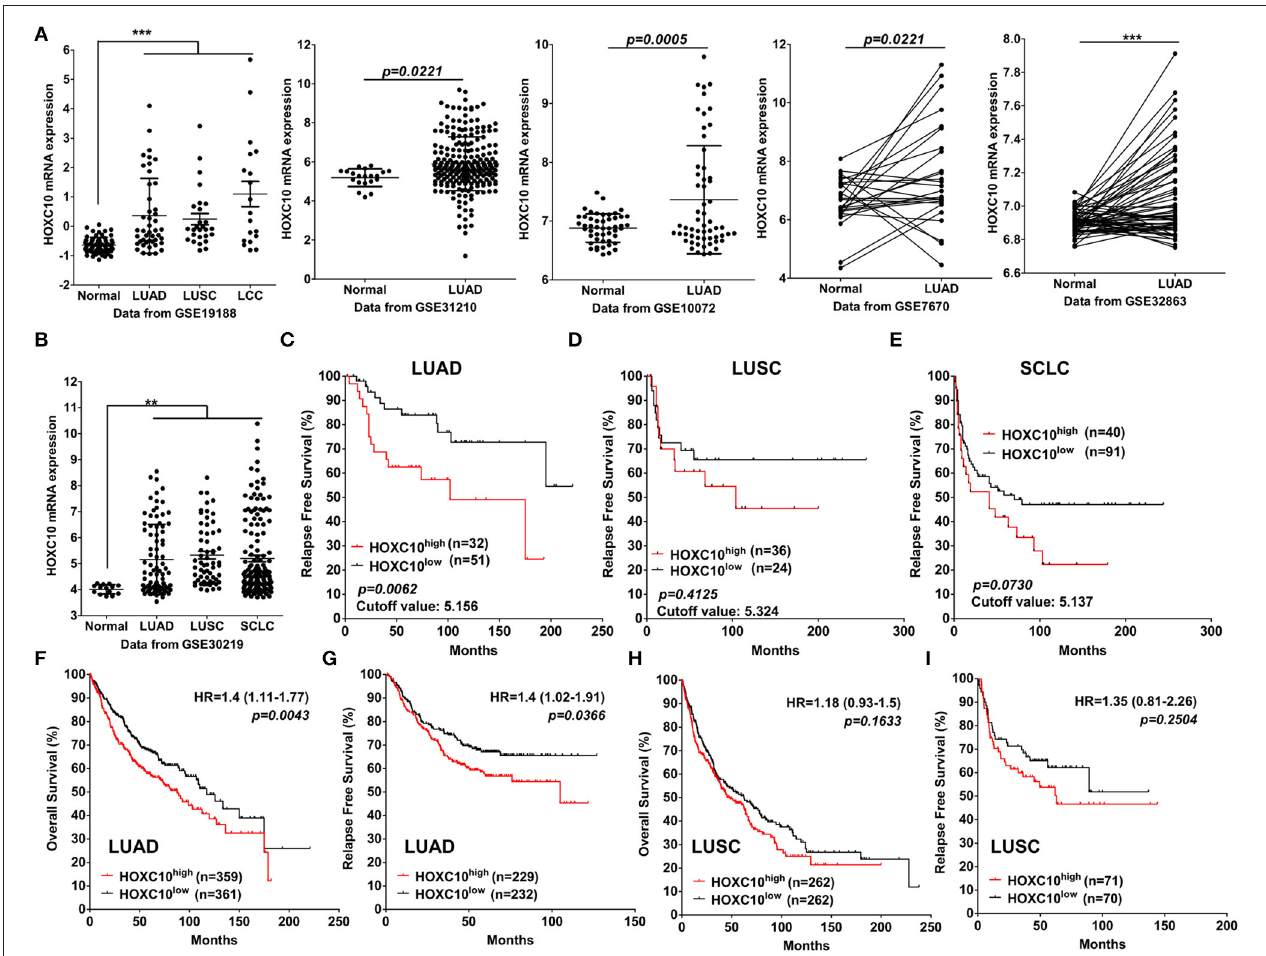
FIGURE 6 | Upregulated HOXC10 indicates poor survival of lung cancer patients. (A) The expression difference of HOXC10 between normal and lung cancer tissues in five GEO datasets (GSE19188, GSE31210, GSE10072, GSE7670, GSE32863, GSE30219), connection line means paired samples. (B) The expression of HOXC10 in lung cancer patients from GSE30219. (C–E) The Kaplan–Meier plot presents the relapse free survival of patients with lung adenocarcinoma (LUAD) (C) , Lung squamous cell carcinoma (LUSC) (D) , small cell lung cancer (SCLC) (E) in GSE30219. (F–I) Overall survival (F) and relapse free survival (G) curves were plotted for LUAD patients, Overall survival (H) and relapse free survival (I) curves were plotted for LUSC patients via the Kaplan–Meier plotter database. Patients with expression above the median are indicated in red line, and patients with expressions below the median in black line. HR means hazard ratio. Data are presented as means ± SD , ** p < 0.01; *** p <